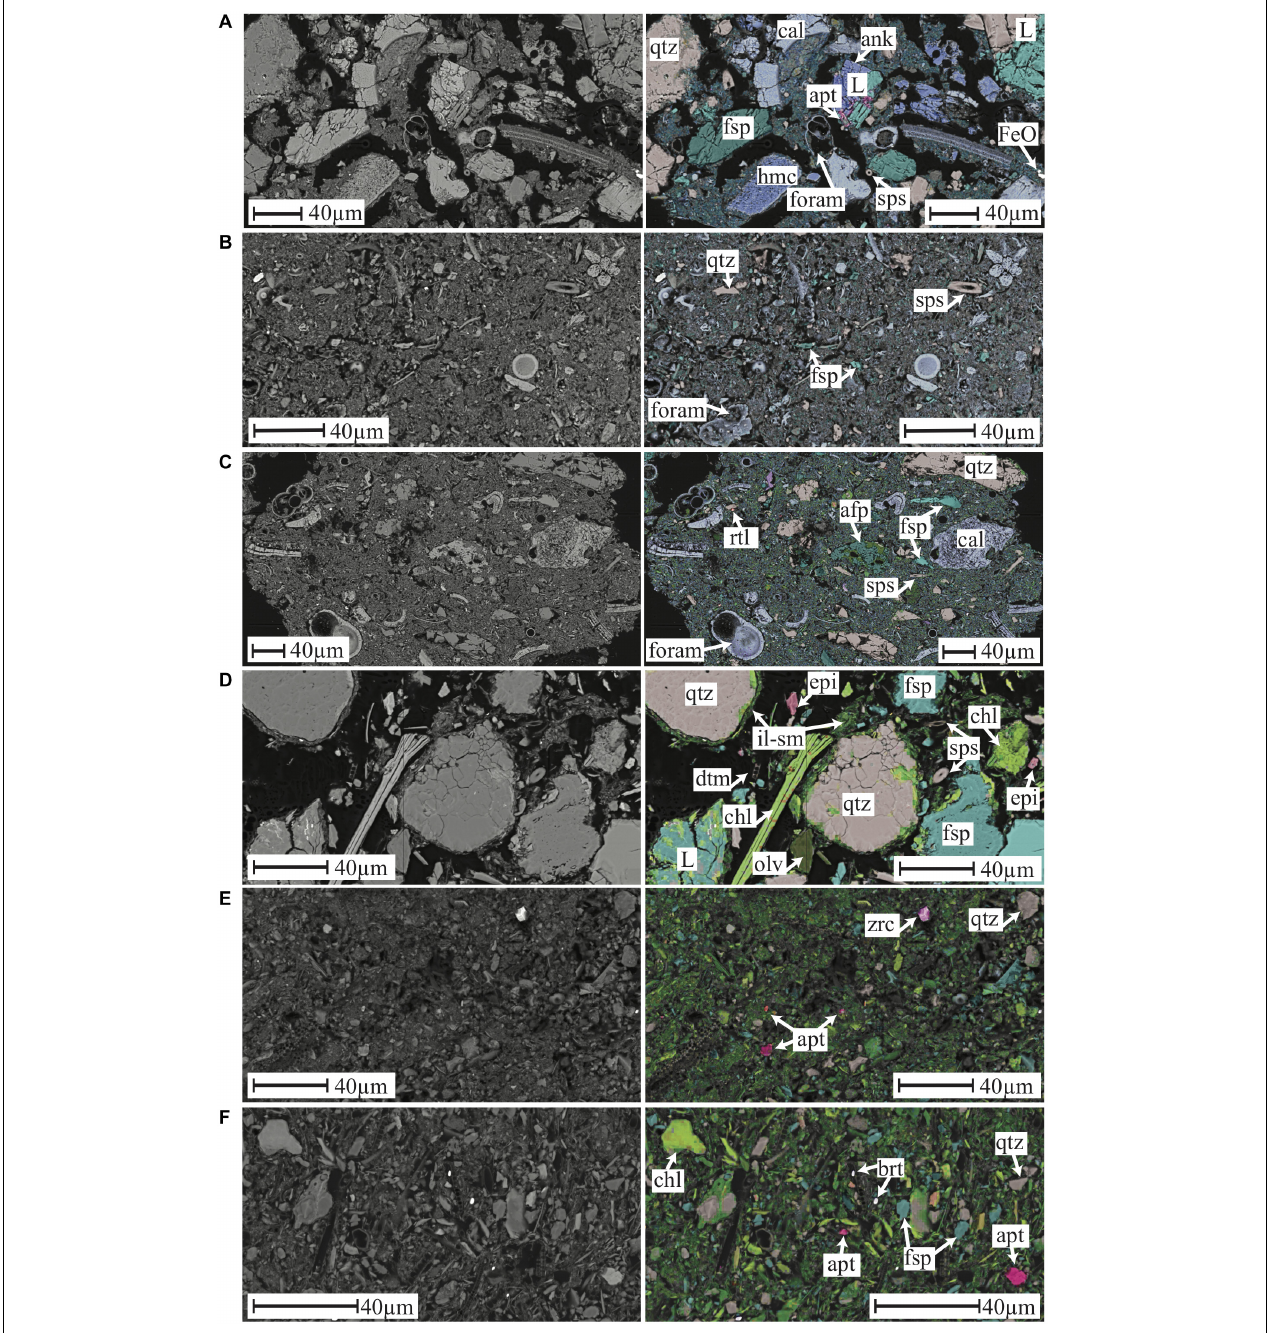
FIGURE 4 | SEM images BSE (left) and mineral map (right) for panel (A) TS200 1–2 cm, (B) TS1500 1–2 cm, (C) TS3000 1–2 cm, (D) NP200 2–3 cm, (E) NP1500 0–1 cm, and (F) NP3000 0–1 cm with selected features labeled as: L, lithic grain; cal, calcite; sps, sponge spicule; ank, ankerite; FeO, iron oxide; dol, dolomite; hmc, high Mg calcite; qtz, quartz; rtl, rutile; fsp, feldspar; afp, feldspar partially weathered to kaolinite; dtm, diatom; zrc, zircon; epi, epidote; olv, olivine; il-sm, illite and smectite; apt, apatite; chl, chlorite; brt, barite. Scale bars are 40 µ m for all panels.